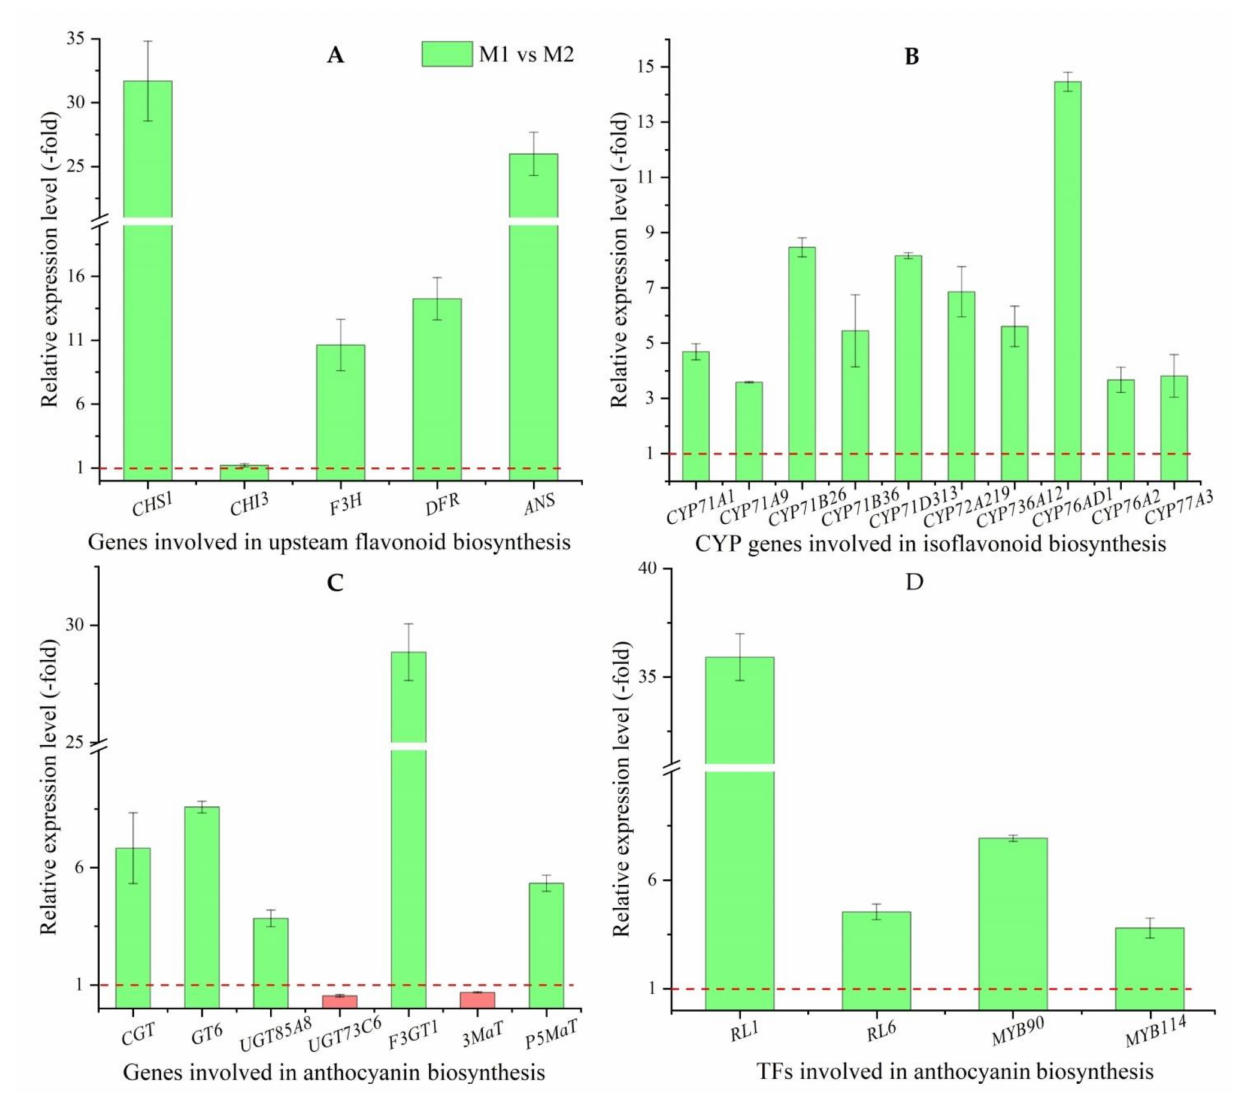
Figure 8. The RELs of genes involved in flavonoid biosynthesis ( A ), isoflavonoid biosynthesis ( B ), anthocyanin biosynthesis ( C ), and TFs ( D ) in M1 vs. M2, as determined by qRT-PCR (mean ± SD, n = 3). The column highlighted in green represents genes favoring flavonoid biosynthesis and red represents genes disfavoring